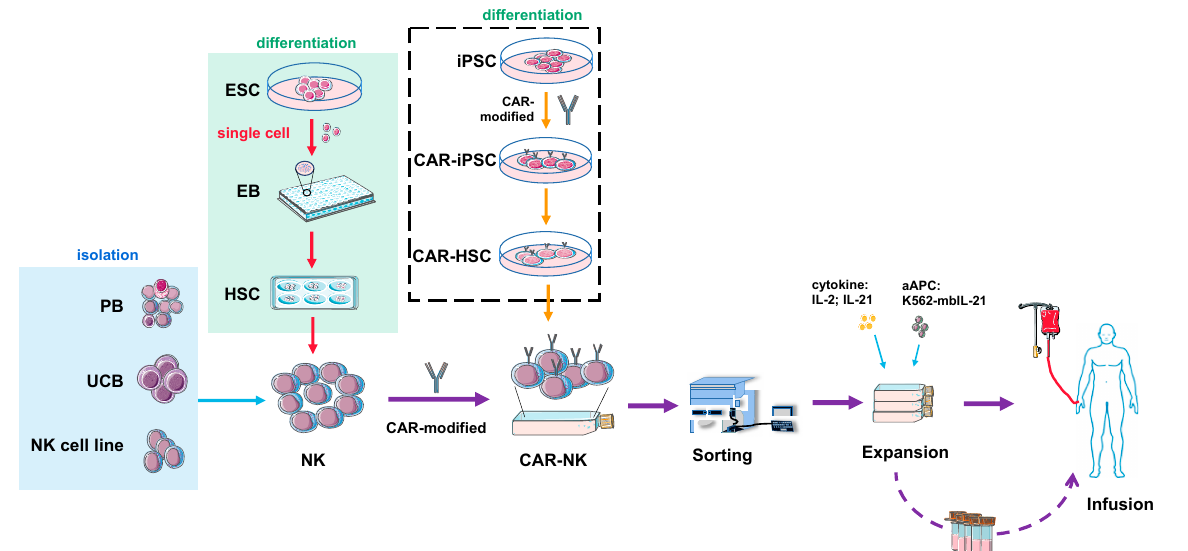
Figure 4. Flow chart of CAR-NK therapy from preparation of NK cells to infusion of patients. NK cells can be either isolated and expanded from primary sources such as PB and UCB or differentiated from ESC or iPSC. CAR molecules are introduced directly into NK cells or at the beginning of differentiation of iPSC. The prepared CAR-NK cells are sorted and further expanded using either cytokine stimulation or an APC cell (K562-mbIL-21). CAR-NK cells can also be cryopreserved for future use.